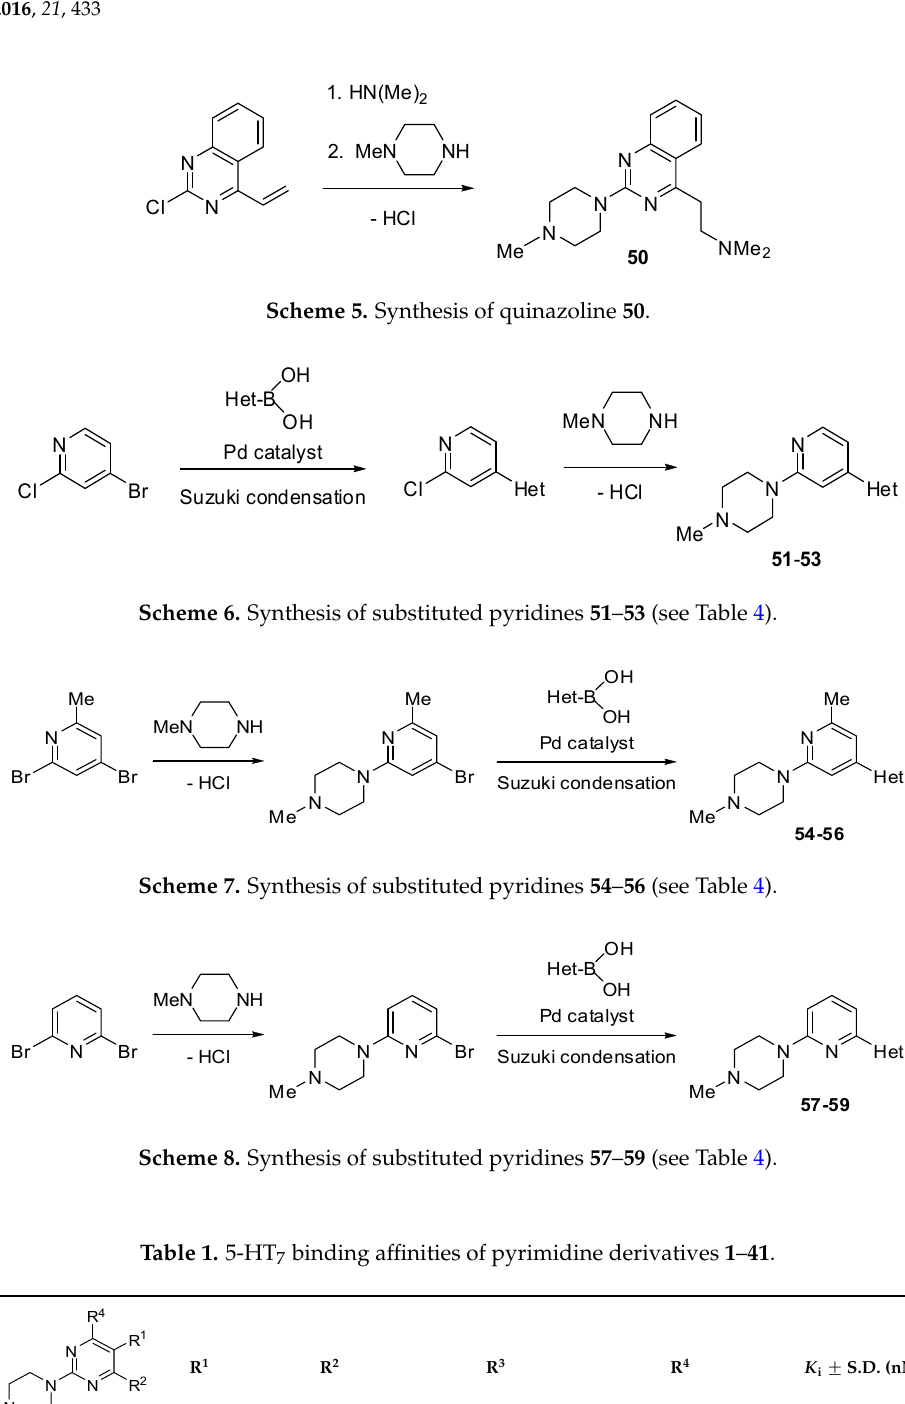
48 Scheme 3. Synthesis of quinazoline 48 .